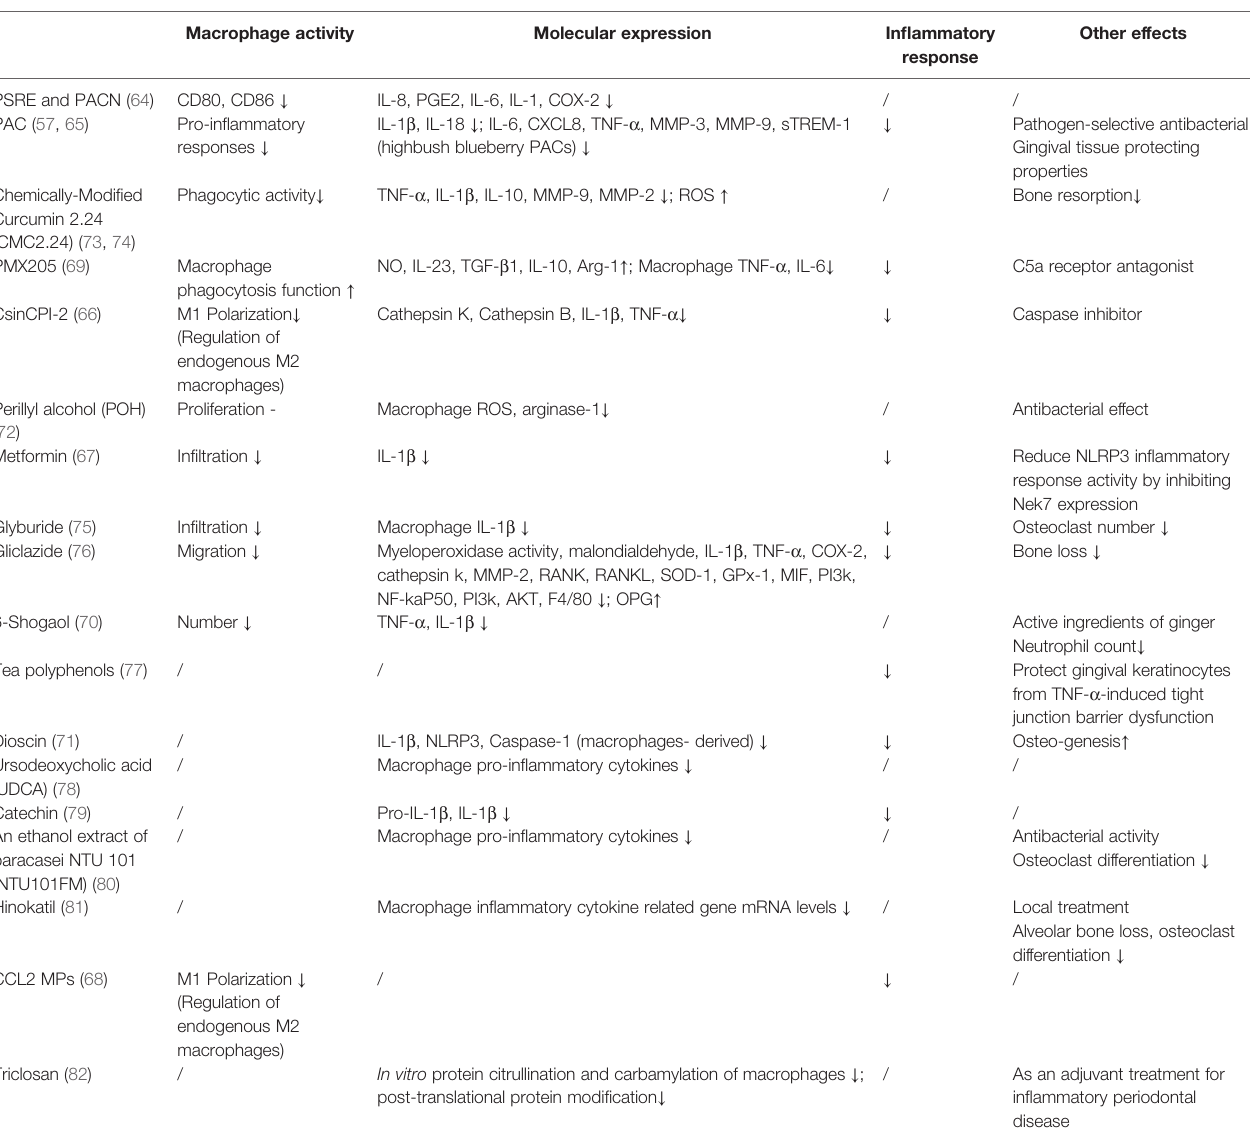
TABLE 1 | Effects of drugs targeting